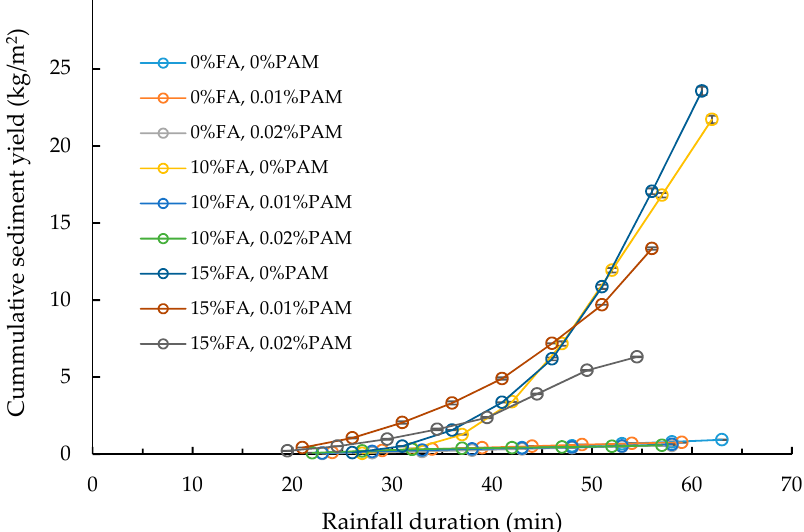
Figure 6. Changes in cumulative sediment yield with rainfall duration for different treatments. The error bars represent one standard deviation ( n = 3).